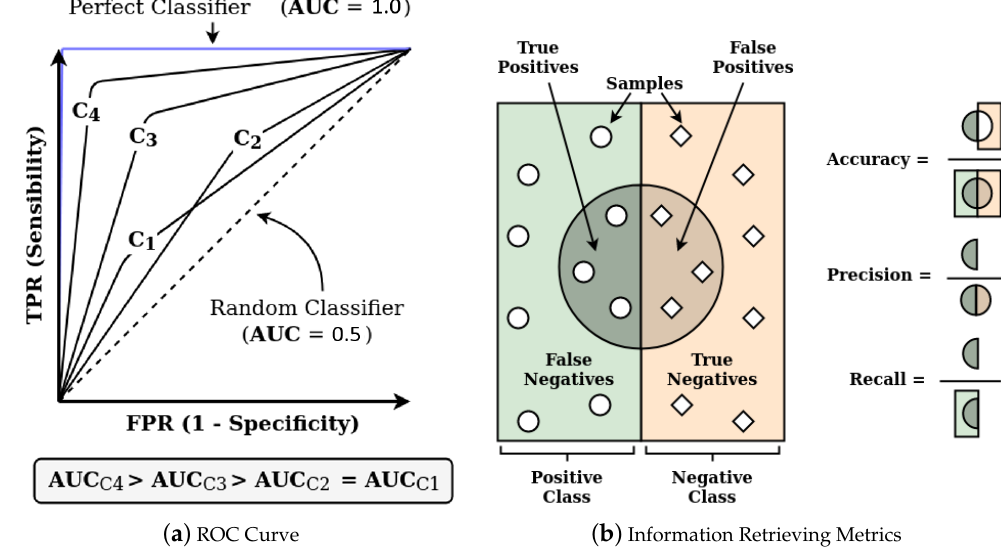
Figure 7. ( a ) Receiver Operation Characteristic (ROC) curve of classifiers and comparison of the Area Under the ROC Curve (AUC). ( b ) Accuracy, precision and sensitivity metrics in a binary classification